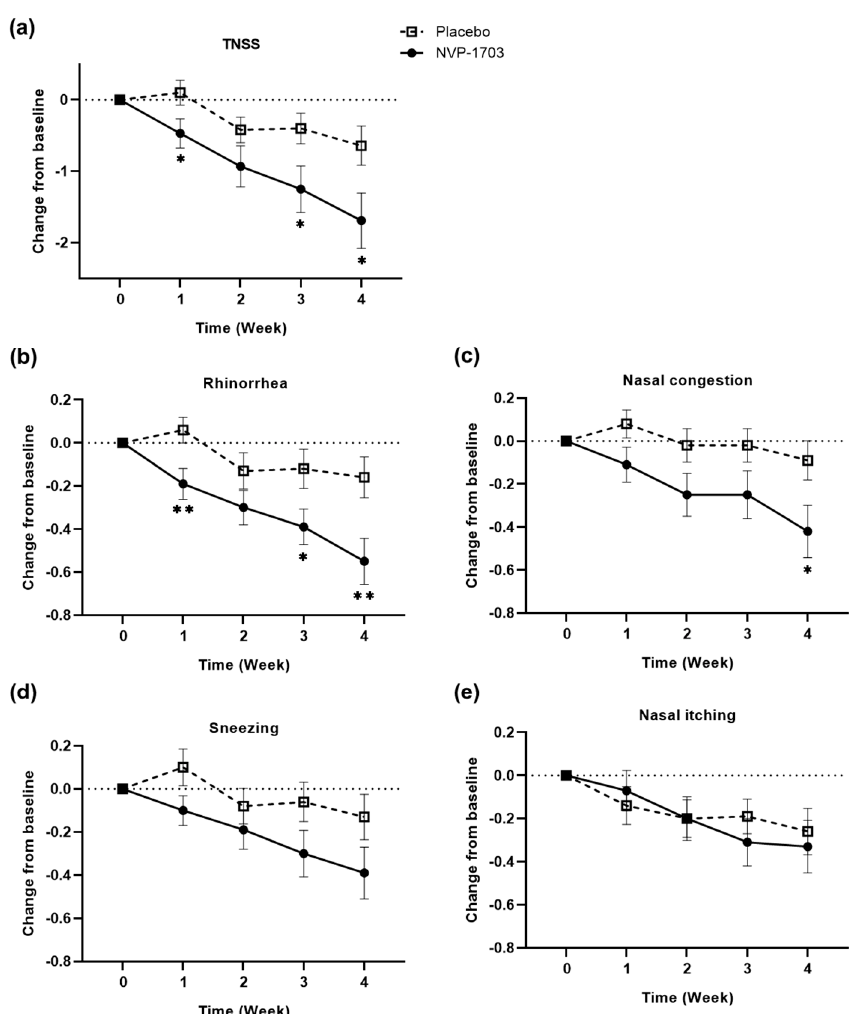
Figure 2. E ff ect of NVP-1703 on ( a ) TNSS and AR symptoms [( b ) rhinorrhea, ( c ) nasal congestion; ( d ) sneezing, and ( e ) nasal itching] scores. Scores are shown as weekly mean change in scores from the baseline for total and individual nasal symptoms during the study period. (*) indicates a statistically significant di ff erence between the two groups (* p < 0.05, ** p <